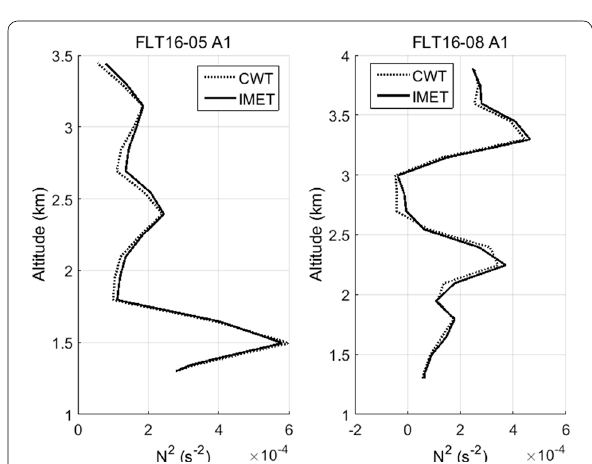
Fig. 11 Vertical profiles of dry N 2 calculated from IMET (solid) and CWT (dotted) sensors at a vertical resolution of 150 m (i.e., the range radar resolution) for FLT16-05 (A1) and FLT16-08